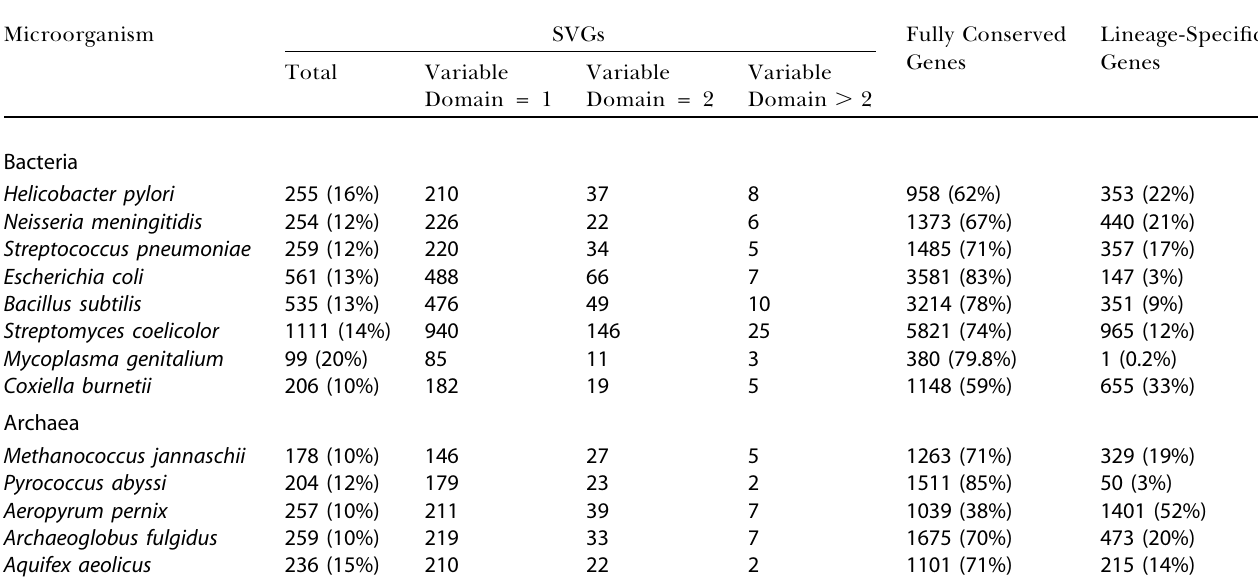
Table 1. Classification of Genes into Three Broad Categories for a Representative Set of Microbial Genomes